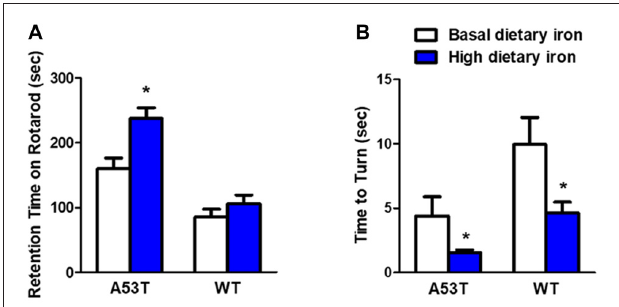
FIGURE 1 | Changes of motor coordination ability in A53T and WT mice with high dietary iron. In A53T mice, the residence time was longer (A) , and the time to turn to orient down-ward was shorter (B) in high dietary iron group compared to the basal dietary iron group. In WT mice, although there was a tendency of the latency to escape to be delayed in rotarod test in high dietary iron group, no significant difference was observed when compared to the basal dietary iron group (A) . The high dietary iron group showed a significant decrease in the time to turn to orient down-ward (B) in the pole test, compared with the basal dietary iron group. Each bar represented the mean ± SEM. ∗ P < 0.05, compared with the corresponding basal dietary iron group, n =